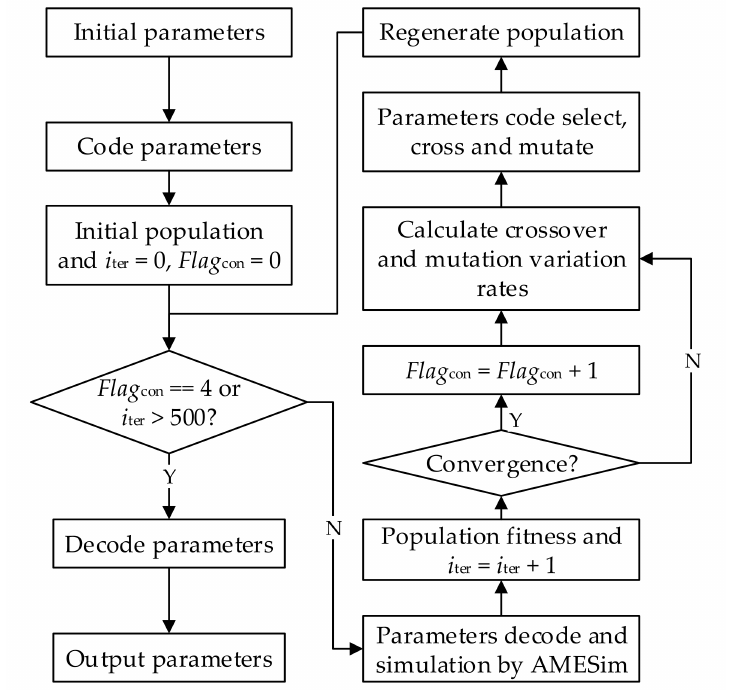
Figure 14. Flowchart of the optimization method.